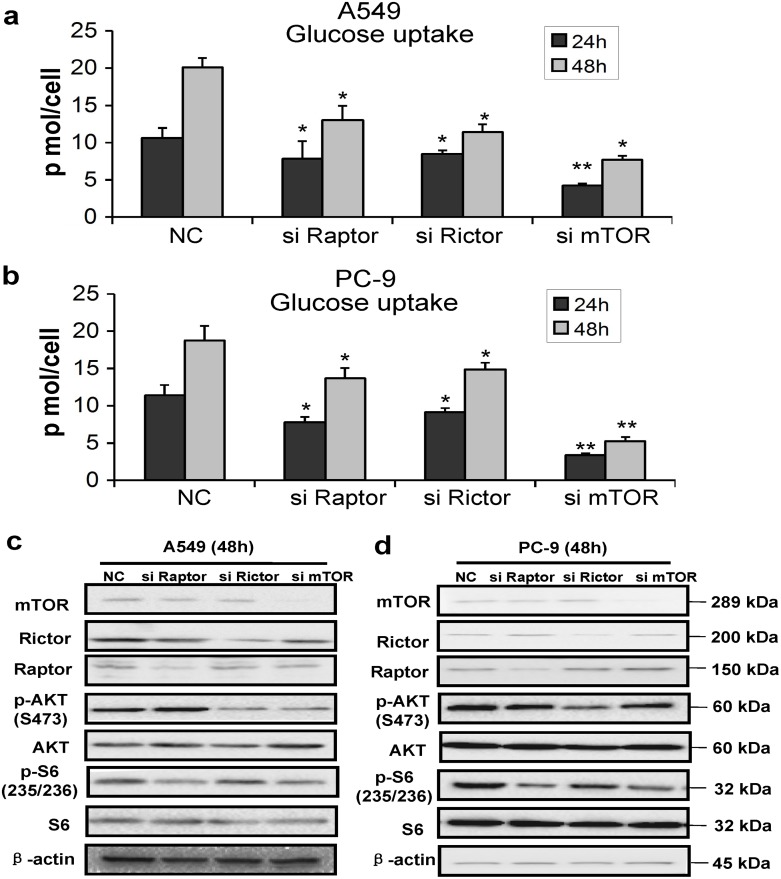
Knockdown of mTOR, Raptor and Rictor decreased the level of glycolytic metabolism in lung cancer cells.(a) and (b) A549 and PC-9 cells were treated with negative control (NC) siRNA or one of those siRNAs targeting Raptor, Rictor, and mTOR. After 24 h and 48 h transfection, the cells were counted and the glucose in the culture media was immediately tested. The results were then normalized to the cells number, and performed as pmol/cell. Data represent mean ± SD (n = 3). *P<0.05, **P<0.01. (c) and (d) Western blot analysis showed that siRNAs against Raptor, Rictor, and mTOR decreased the protein expression of Raptor, Rictor, mTOR, AKT, p-AKT, S6, and p-S6, respectively. Three independent experiments were performed with similar results, and representative data are shown.